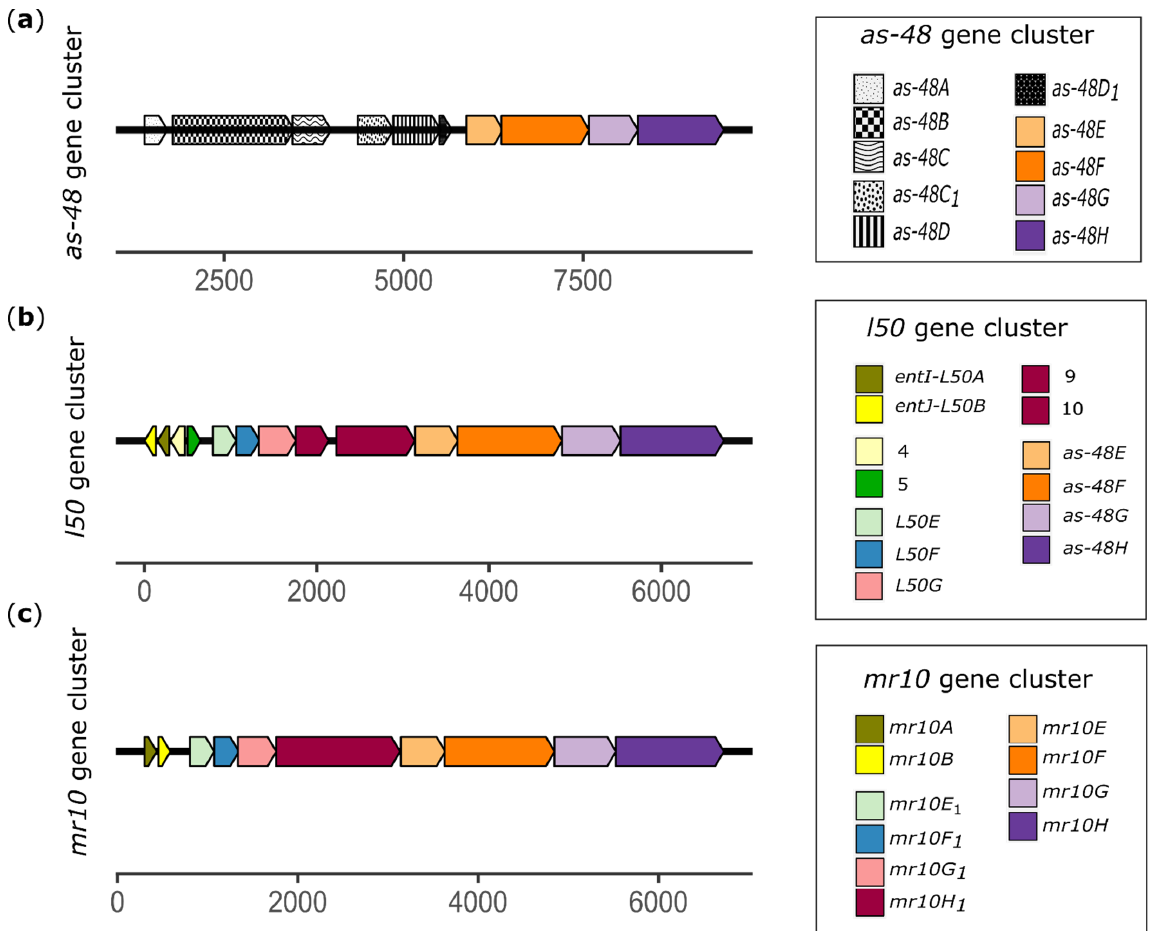
Figure 2. Genetic organization of AS-48, MR10A/B and L50A/B enterocins. ( a ) Ten identified open reading frames (ORFs) are depicted in the as-48 gene cluster, all running in the same direction: as-48A (dotted pattern) is the structural gene; as-48B (squared pattern) appears to be involved in biosynthetic machinery; as-48C (wavy pattern) may encode an auxiliary immunity protein; as-48C 1 (large dotted pattern) and as-48D (striped pattern) form the first pump involved in bacteriocin secretion; as-48D 1 (black) encodes an immunity protein; as-48E (light orange), as-48F (dark orange), as-48G (light violet), and as-48H (dark violet) form a second pump constituted by an ABC transporter-2 involved in self-immunity. ( b ) Gene cluster of L50A/B enterocins. A total of 13 identified ORFs [26] are depicted . l50A and l50B are the structural genes for enterocins (yellow and olive-green arrows), which are arranged in the opposite orientation to the remaining genes. orf4 and orf5 (beige and green arrows) with unknown functions. L50E , L50F , and L50G (light blue, blue and pink arrows, respectively) may encode transporters of the ABC type orf9 and orf10 (maroon arrows) with unknown function. Finally, as-48E (light orange), as-48F (dark orange), as-48G (light violet), and as-48H (dark violet) constitute a second pump formed by an ABC transporter-2. ( c ) Gene cluster of MR10A/B enterocins. Ten identified ORFs are depicted, all running in the same direction. mr10A and mr10B (olive green and yellow arrows) are the structural genes for MR10A and MR10B enterocins; mr10E 1 (light blue arrow) encodes a DUF (domain of unknown function) protein family; mr10F 1 and mr10G 1 (blue and pink arrows) encode two proteins of unknown function. mr10H 1 gene ( maroon arrow ) encodes a PH domain-containing protein, and mr10E , mr10F , mr10G , and mr10H (light orange, dark orange, light violet, and dark violet arrows, respectively) represent a pump constituted by an ABC transporter.